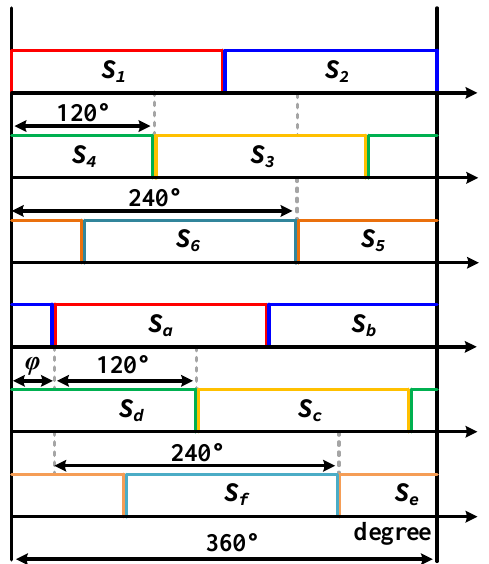
Figure 2. Power switch control signal.